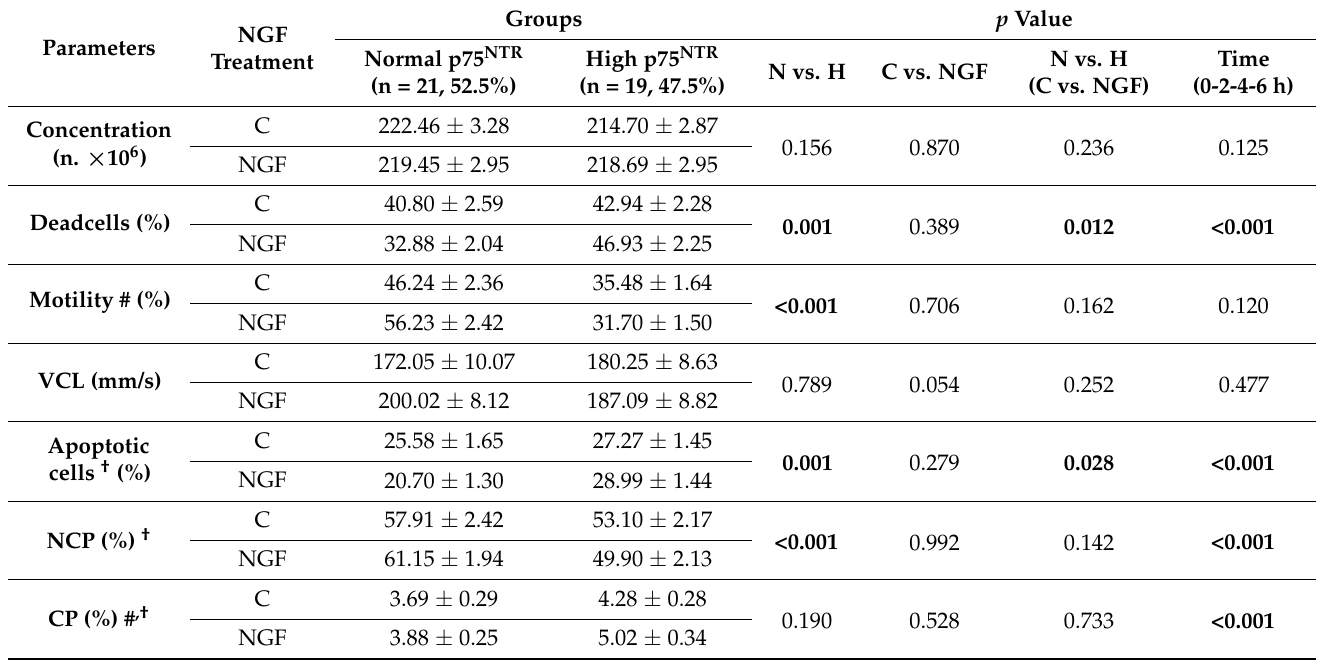
Table 3. Changes in ejaculated sperm traits, NFG, and p75 NTR in semen of Normal ( ≤ 25.6%, N) and High (>25.6%, H) p75 NTR -positive cells during storage (from 2 to 6 h after